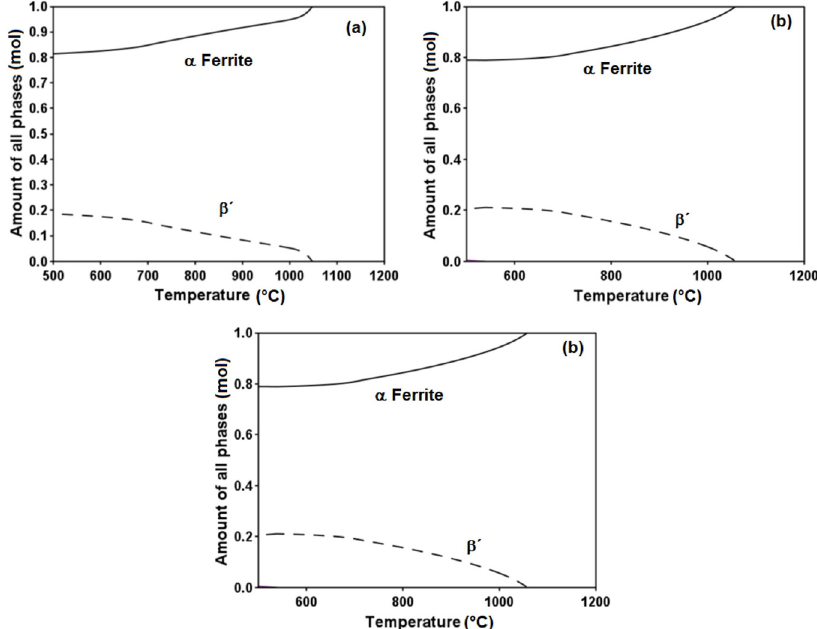
Figure 2. Calphad calculated plot of amount of all equilibrium phases versus temperature for (a) Fe-10at.%Ni-15at.%Al, (b) Fe-10at.%Ni- 15at.%Al-2.5at.%Cu and (c) Fe-10at.%Ni-15at.%Al-5at.%Cu alloys.